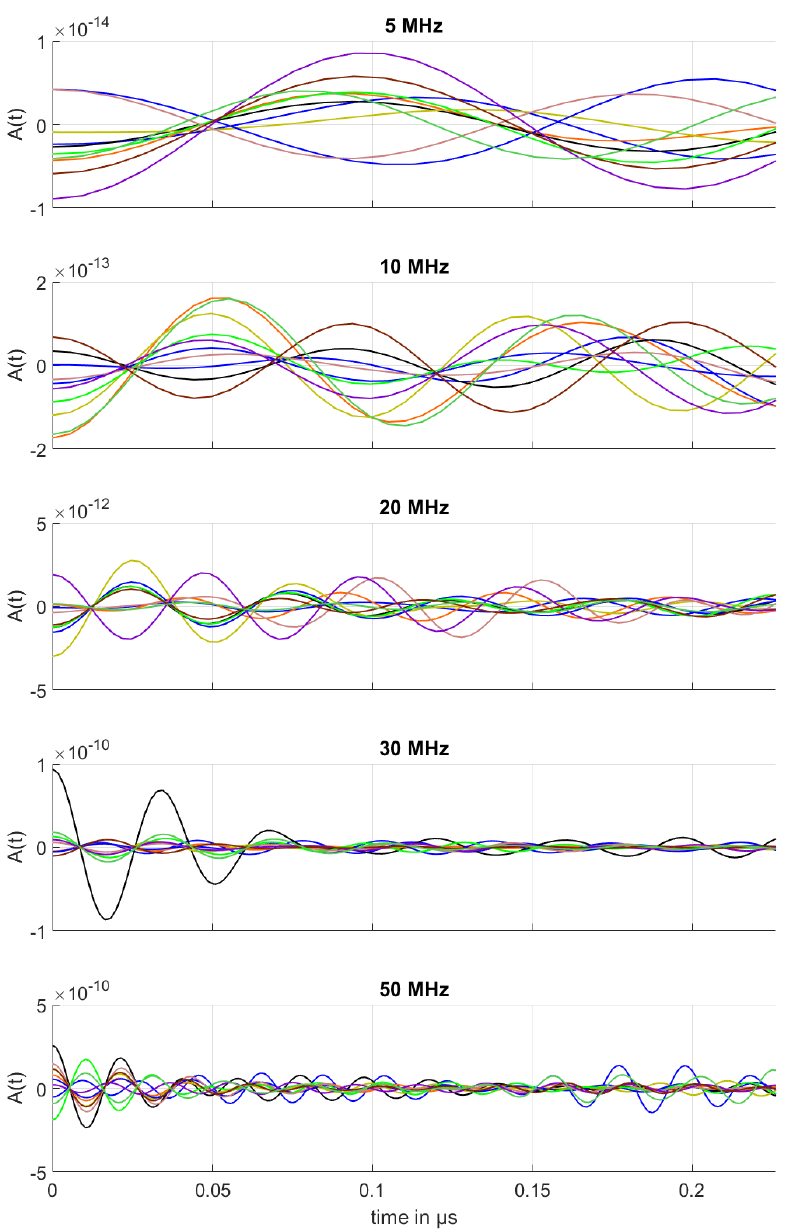
Figure 19. Received backscattered signals in titanium for a sequence of testing frequencies f = 5, 10, 20, 30 and 50MHz. The corresponding transducer is modeled as a circle with diameters 3mm for frequency 50MHz and 6mm for all other frequencies, which emits and receives longitudinal